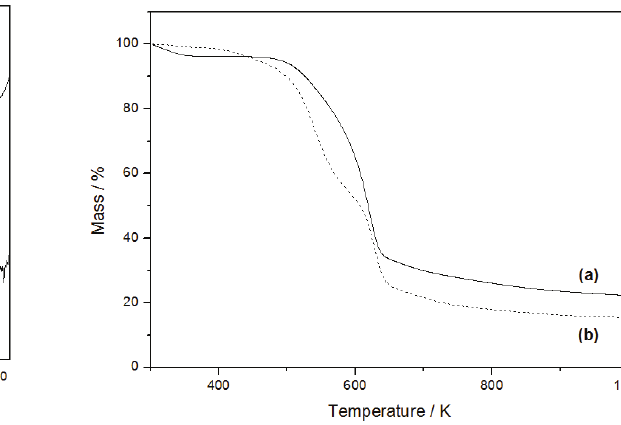
Figure 1 - Infrared spectra of wood sawdust, WS (a) and wood sawdust modified with succinic anhydride, SSA (b) .